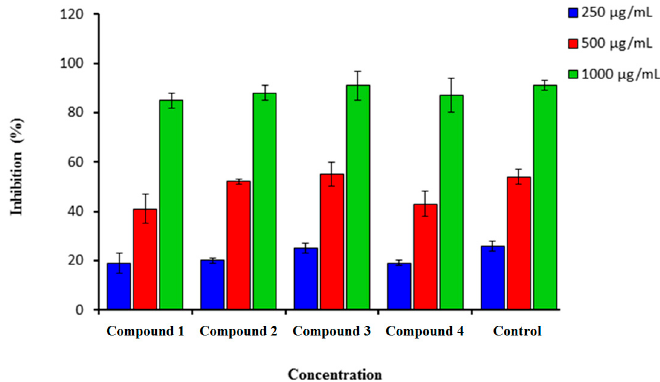
Figure 1. Percentage inhibition of DPPH scavenging activity of synthesized compounds ( 1 – 4 ) in comparison to Vitamin C. n = 3. Error bars indicate standard deviation.